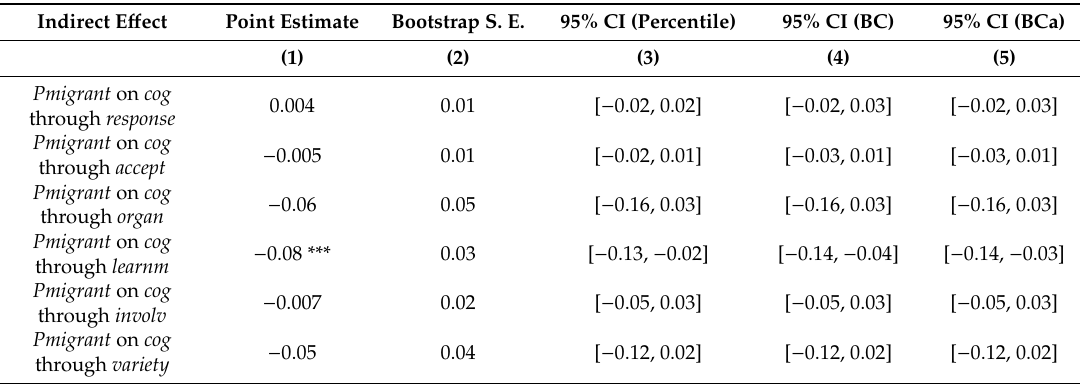
Table 4. Estimates of indirect e ff ects of parental migration on cognitive development through di ff erent dimensions of home